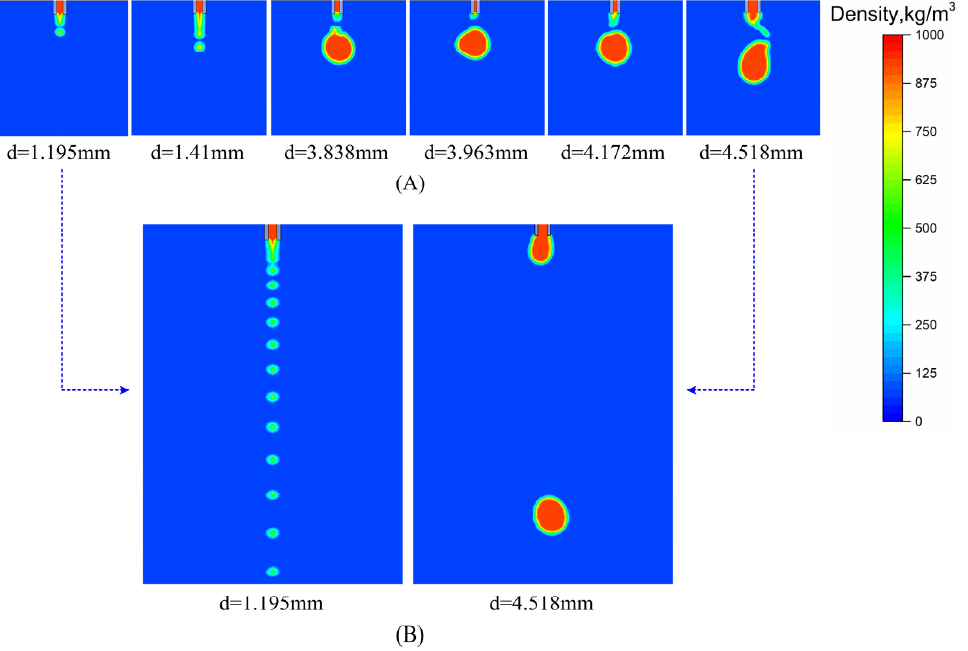
Figure 3. Evolution of a single droplet at di ff erent time steps: ( A ) formation of a single droplet with di ff erent initial diameters; ( B ) contour of the drop trajectory.